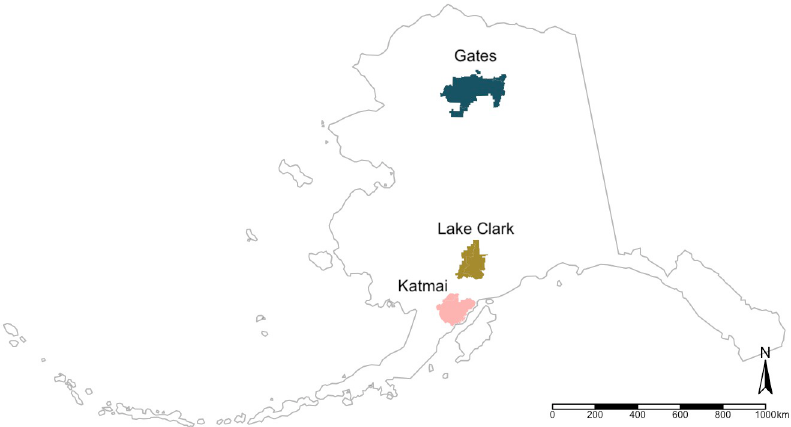
Fig 1. Map of brown bear study areas. Katmai National Park and Preserve (Katmai; n = 33), Lake Clark National Park and Preserve (Lake Clark; n = 12), and Gates of the Arctic National Park and Preserve (Gates; n = 21). Map created using R (version 4.0.2.; R Core Team 2020), RStudio (version 1.3.1056; RStudio Team 2020), sf (R, version .0–7), tmap (R, version 3.3–3), and spData (R, version 2.0.1). Park boundary shapefile from National Park Service (https://irma.